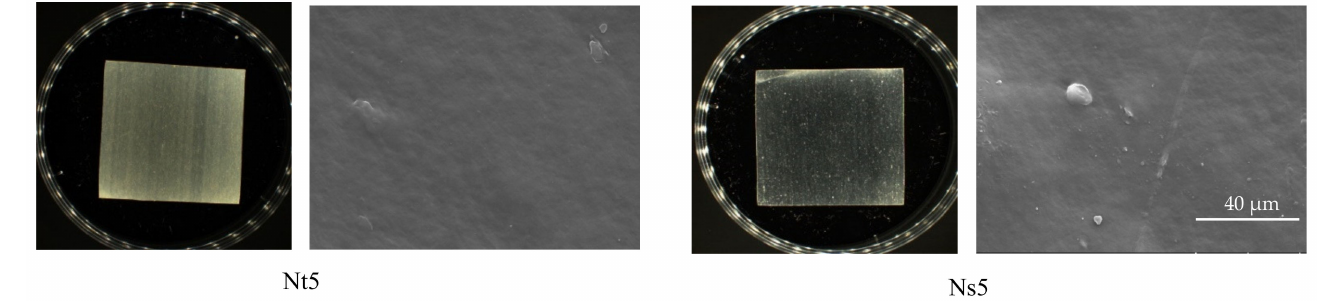
Figure 1. Sample images (real photos and photos taken with a scanning electron microscope-SEM, Hitachi SU 8010, Tokyo, Japan). Abbreviations: 0- pure LDPE; Nt 1,3,5 (samples with 1%, 3% and 5% Natamax ® ); Ns 1,3,5 (samples with 1%, 3% and 5% Nisaplin ® ).